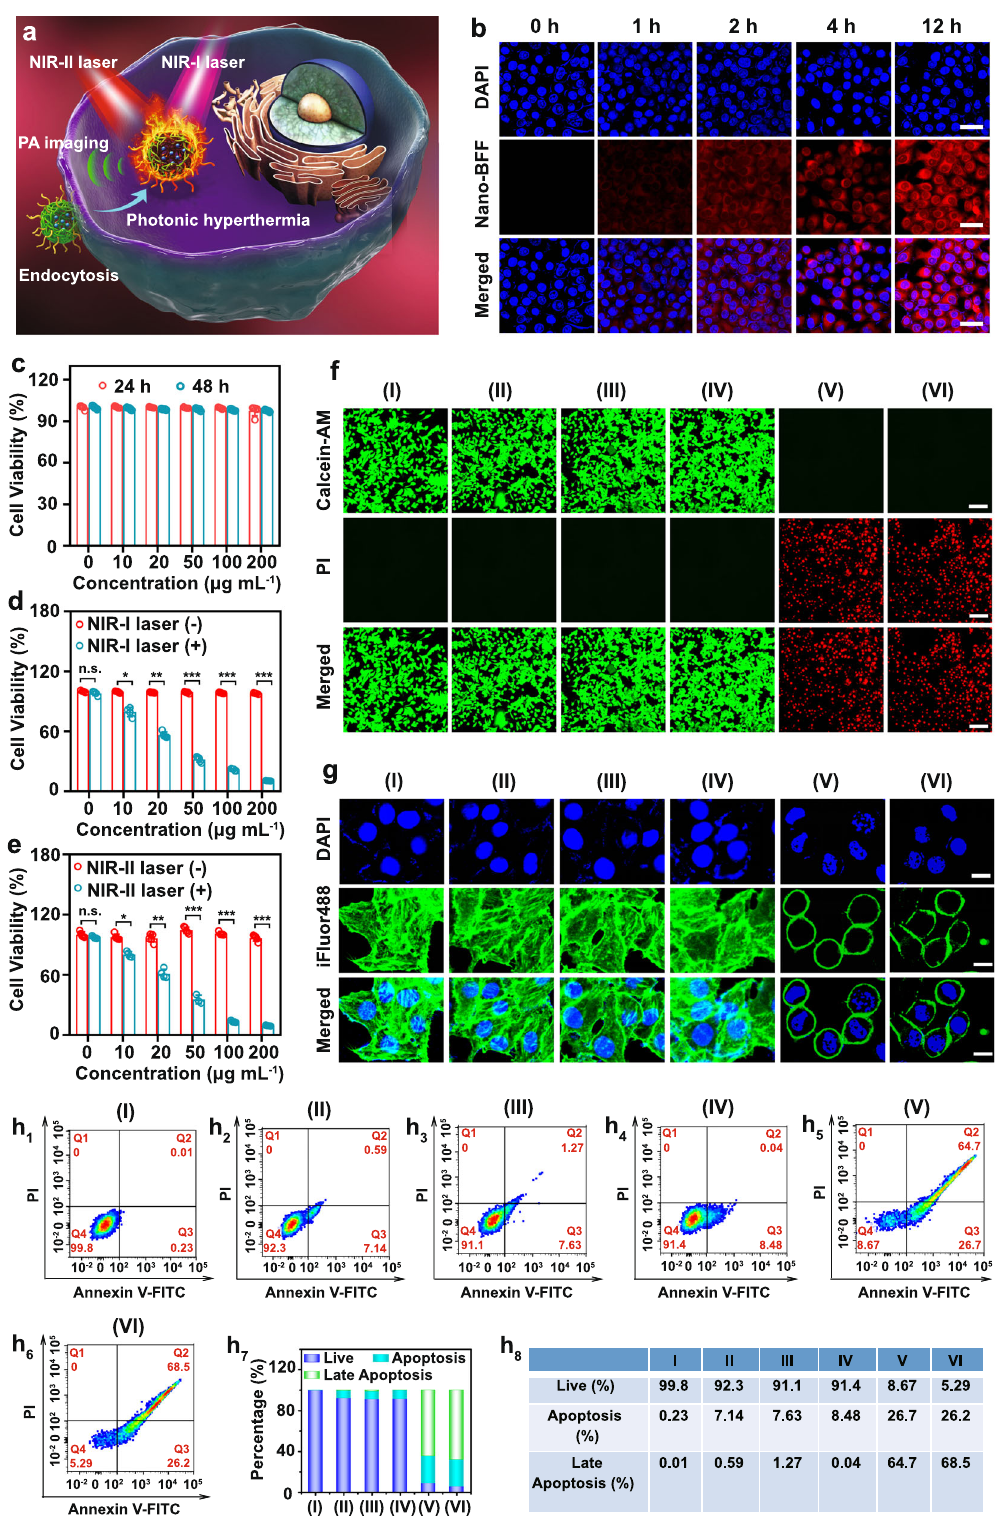
Fig. 3 Intracellular uptake and in vitro photonic hyperthermia of Nano-BFF. a Scheme of in vitro PTT treatment by Nano-BFF. b Confocal images of 4T1 cells administrated with Cy3-labeled Nano-BFF at varied time points (scale bars: 50 μ m). c Cell survival rates of 4T1 cells administrated with Nano-BFF at elevated doses for 24 and 48h ( n = 5 biologically independent samples). d , e Cell survival rates of 4T1 cells treated with various concentrations of Nano-BFF under d 808nm and e 1064nm laser exposure for 10min ( n = 5 biologically independent samples). Data are presented as mean values ± SD. n.s.: not signi fi cant. p > 0.05; * p <0.05; ** p <0.01; *** p <0.001, analyzed by Student ’ s two-sided test. f , g Fluorescence images of 4T1 cells after treated with various disposes. The cells were stained by f calcein-AM/PI (scale bars: 100 μ m) and g DAPI/iFluor 488 (scale bars: 20 μ m) before the analysis by CLSM. h 1 – 8 Apoptosis pro fi les of 4T1 cells after treated with various disposes (I: PBS; II: NIR-I laser; III: NIR-II laser; IV: Nano-BFF; V: Nano-BFF + NIR-I laser; VI: Nano-BFF + NIR-II laser).